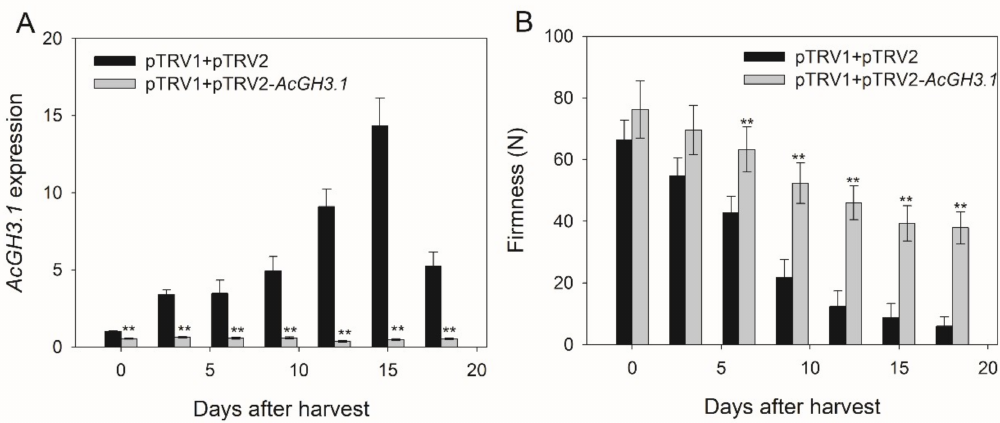
Figure 4. E ff ects of AcGH3.1 silence on ( A ) AcGH3.1 expression and ( B ) firmness during kiwifruit postharvest storage. Expression of Actin was used as an internal control and to normalize the expression of AcGH3 genes. Error bars show the standard error between three replicates performed. Asterisks indicate a significant di ff erence relative to pTRV1 + pTRV2 according to a student’s t-test (** p <